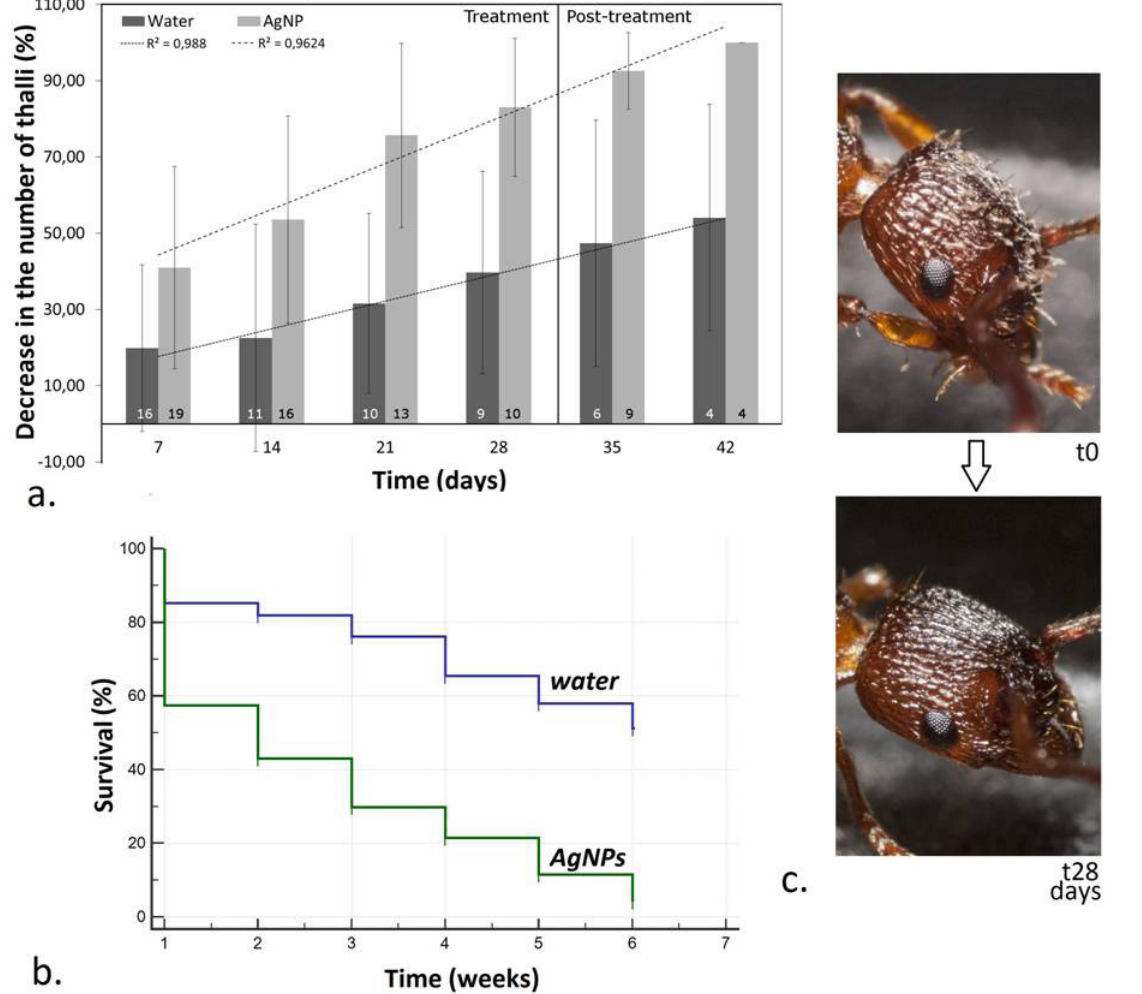
Fig 1a. Decrease in the number of thalli (in percentage) on AgNP-treated and control (water-treated) ants during the 4 weeks of treatment and the 2 weeks of post-treatment tracking. Number of hosts in each group on bars, error bars show SD. b. Survival of thalli in the two groups. c. Example of a completely treated host ant on 1 st and 28 th day of AgNP